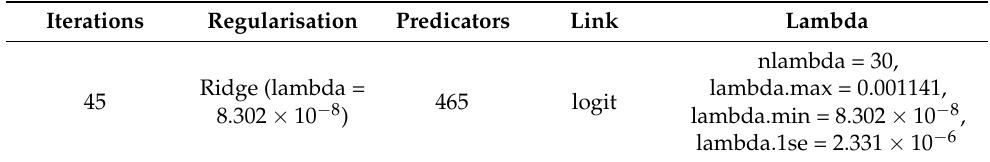
Table 4. GLM parameters.